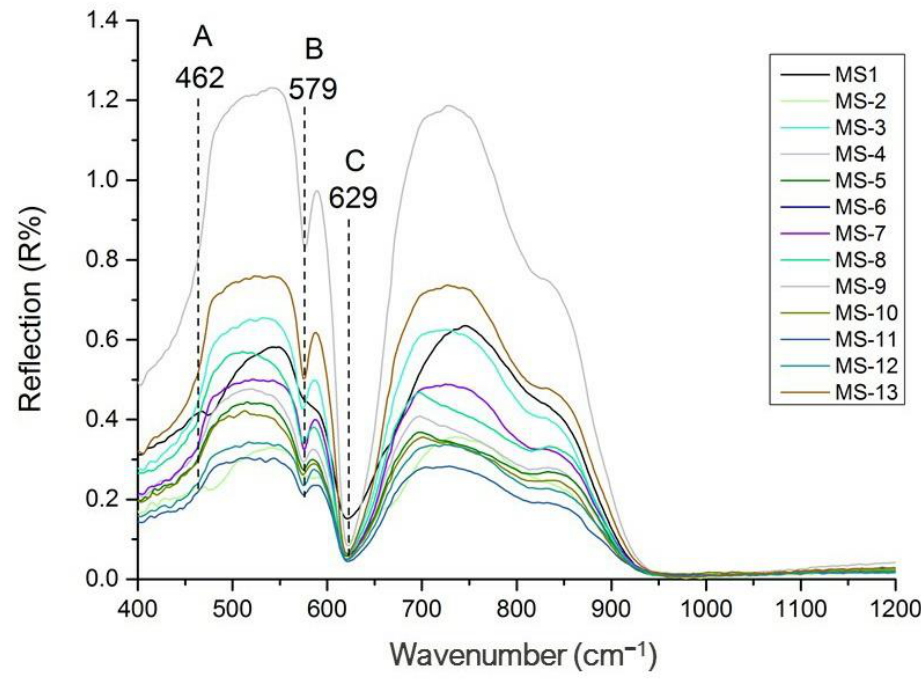
Figure 9. Fourier transform infrared (FTIR) spectroscopy of ‘Jedi’ spinel from Man Sin.